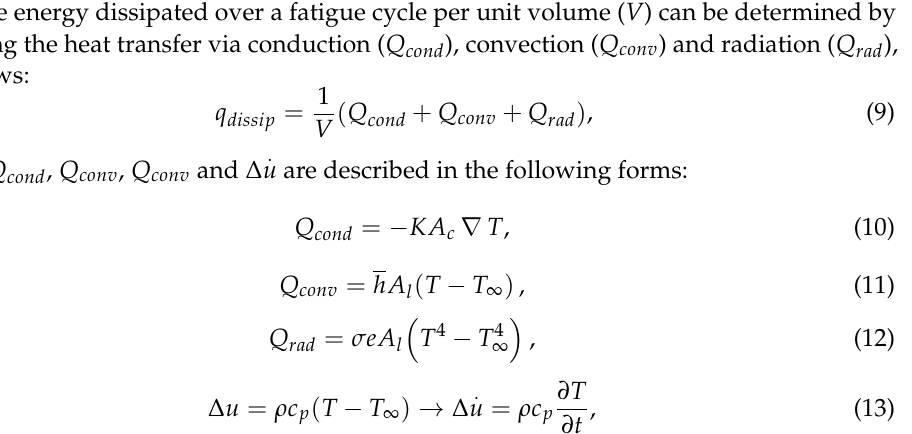
Figure 13. Schematic representation of the generated hysteresis loop and energy-based parameters.